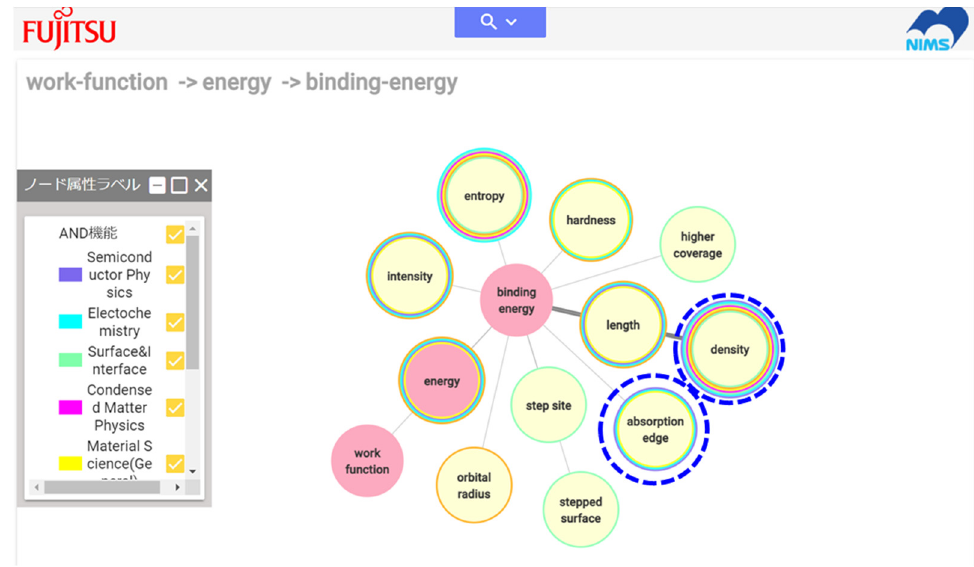
Figure 11. Results screen for sequential network search starting from work function.